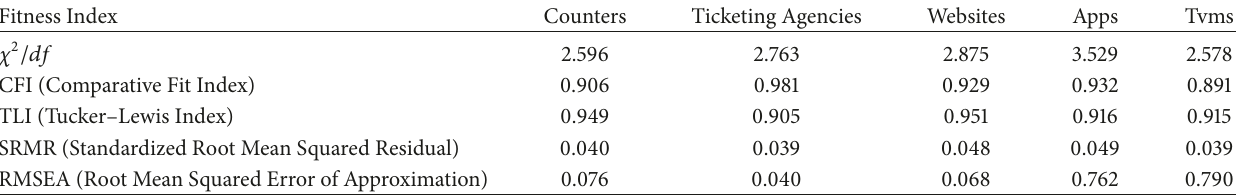
Table 5: Goodness of fit indices of Multiple Indicator Multiple Cause (MIMIC)